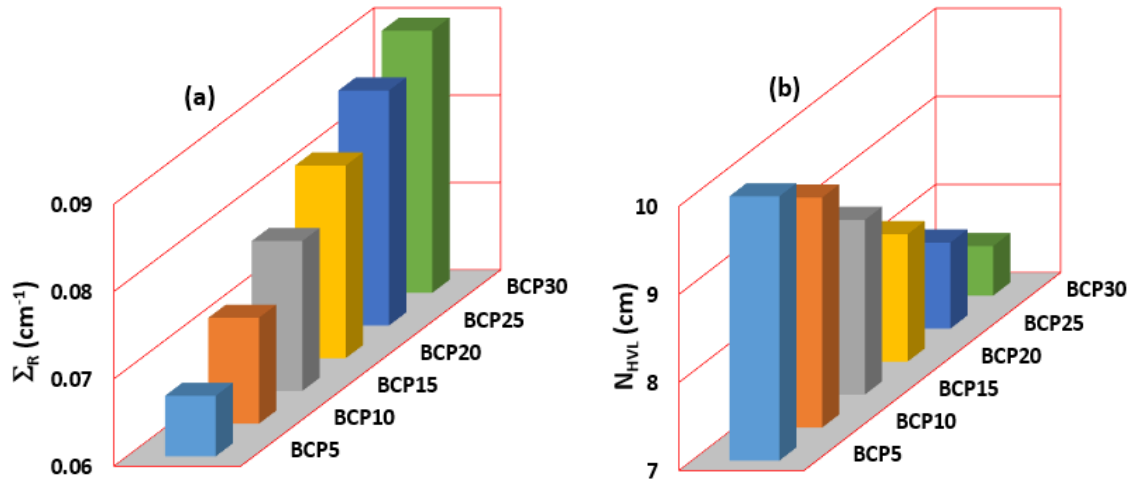
Figure 10. ( a ) Fast neutron removal cross-sections (Σ R ) and ( b ) half-value layer for neutron radiation N HVL values for all glass samples.